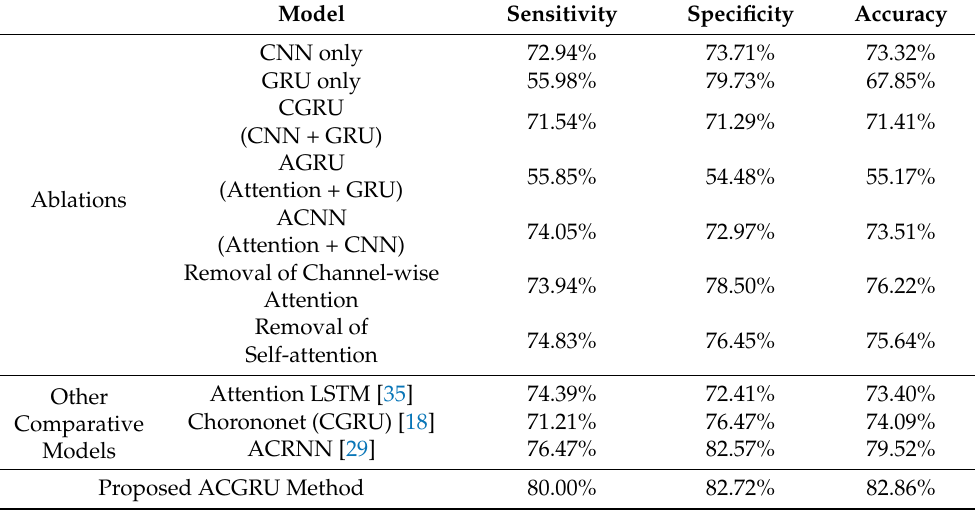
Table 5. The comparison of classification performance between the proposed ACGRU model, ablation model, and the models employed in other studies. Our dataset was used for each